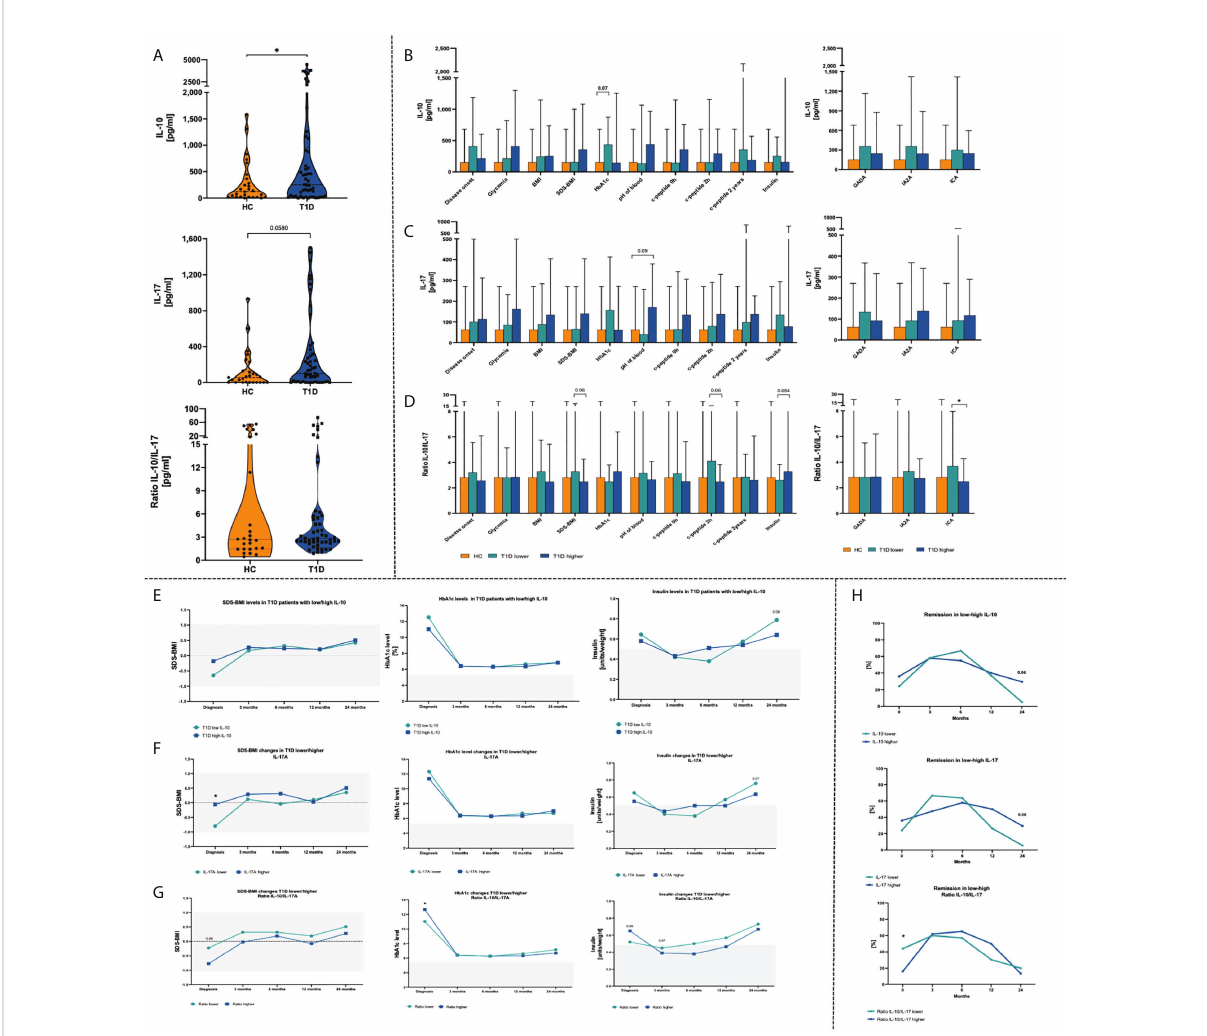
FIGURE 3 Changes in plasma cytokines in the T1D patients. Admission stage values of IL-10, IL-17 and IL-10/IL-17 ratio (A) . Effects of IL-10 (B) , IL-17 (C) and their ratio (D) on the clinical parameters in the studied groups. Time-related variations in SDS-BMI, HbA1c and insulin dosage in context of low/high IL-10 (E) , IL-17 (F) and IL-10/IL-17 ratio (G) . Variations in remission rates depending on IL-10 and IL-17 T1D patients (H) . The levels of signi fi cant differences were indicated with asterisks or exact p values: * - p <